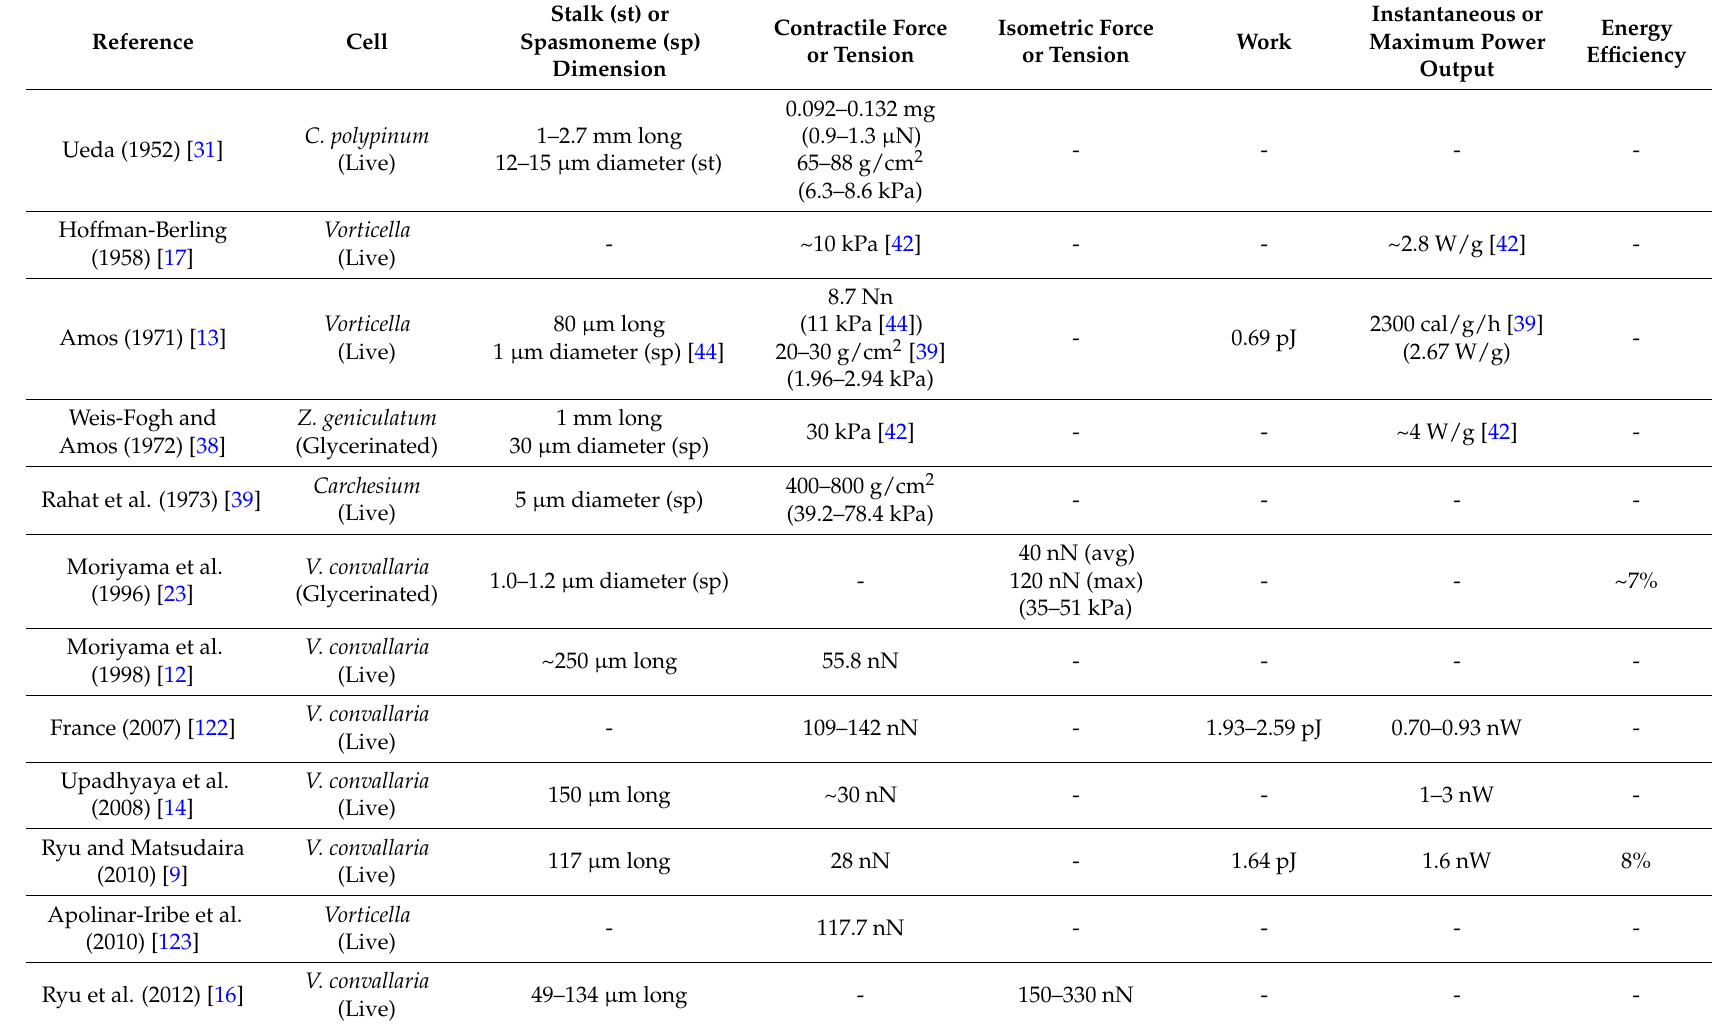
Table 2. Tension and energetics of the stalk contraction of Vorticella and its relatives (in